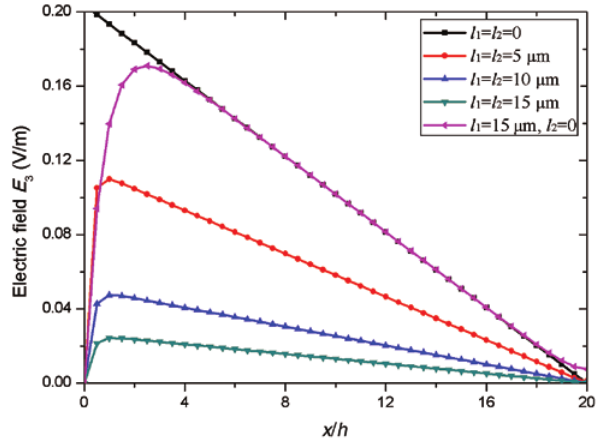
at z = h /2 along the beam 3